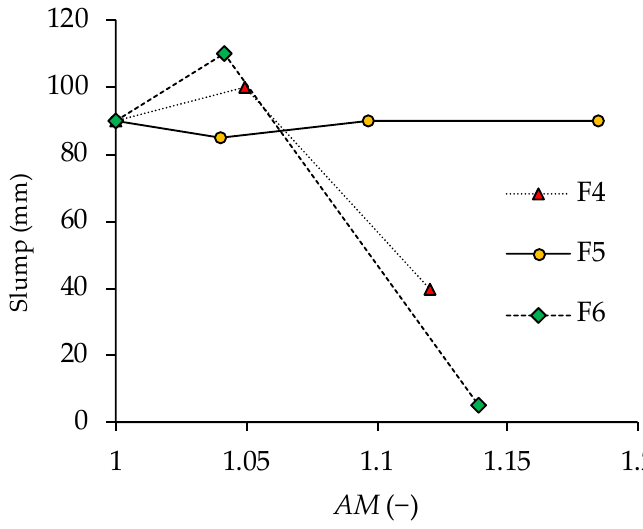
Figure 5. Slump vs. area multiplier ( AM ) in concrete .